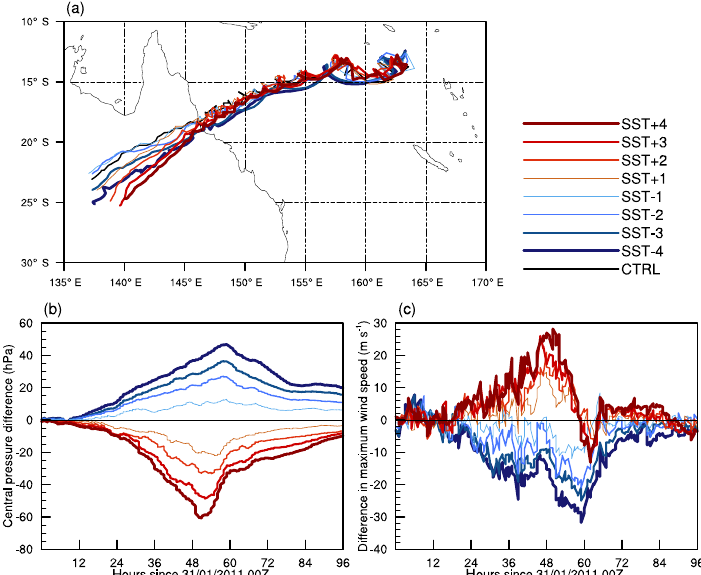
Figure 4. (a) Tracks of TC Yasi from all nine simulations and time series showing the difference (SST runs minus CTRL) in (c) minimum pressure (hPa) and (b) maximum wind speed (ms − 1